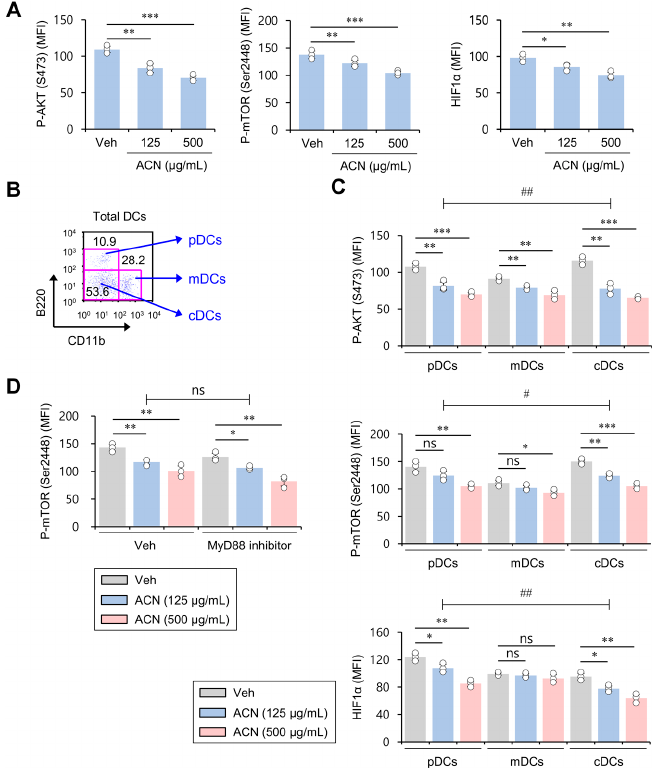
Figure 2. ACN treatment down-regulates basal AKT/mTOR/HIF1 α signaling in DCs in a MyD88- independent fashion in vitro. ( A – C ) Splenic CD11c + DCs were purified from B6 mice using a MACS system, and DCs were cultured with ACNs (125 and 500 μ g/mL) for 16 h. ( A ) Intracellular expres- sion of P-AKT, P-mTOR, and HIF1 α in DCs was assessed via flow cytometry. ( B ) Splenic DCs were cultured with ACNs (125 and 500 μ g/mL). The percentage of three subsets (pDCs (CD11b − B220 + ), mDCs (CD11b + B220 − ), and cDCs (CD11b − B220 − )) among splenic DCs was evaluated using flow cy- tometry. ( C ) Intracellular expression of P-AKT, P-mTOR, and HIF1 α was determined in DC sub- populations (pDCs, mDCs, and cDCs) via flow cytometry. Two-way ANOVA (ACN × MyD88 in- hibitor) showed an interaction between these two factors ( # p < 0.05, ## p < 0.01). ( D ) Splenic DCs were cultured for 16 h with either vehicle (Veh) or MyD88 inhibitor (T6167923; 500 μ M) in the absence or presence of ACNs (125 and 500 μ g/mL). Intracellular expression of P-mTOR in DCs was assessed via flow cytometry. Two-way ANOVA (subpopulation × ACN) showed an interaction between these two factors. The mean values ± SD ( n = 3; per group in the experiment; Student’s t -test; * p < 0.05, ** p < 0.01, *** p < 0.001) are shown. One representative experiment of three experiments is shown. ns, not significant.